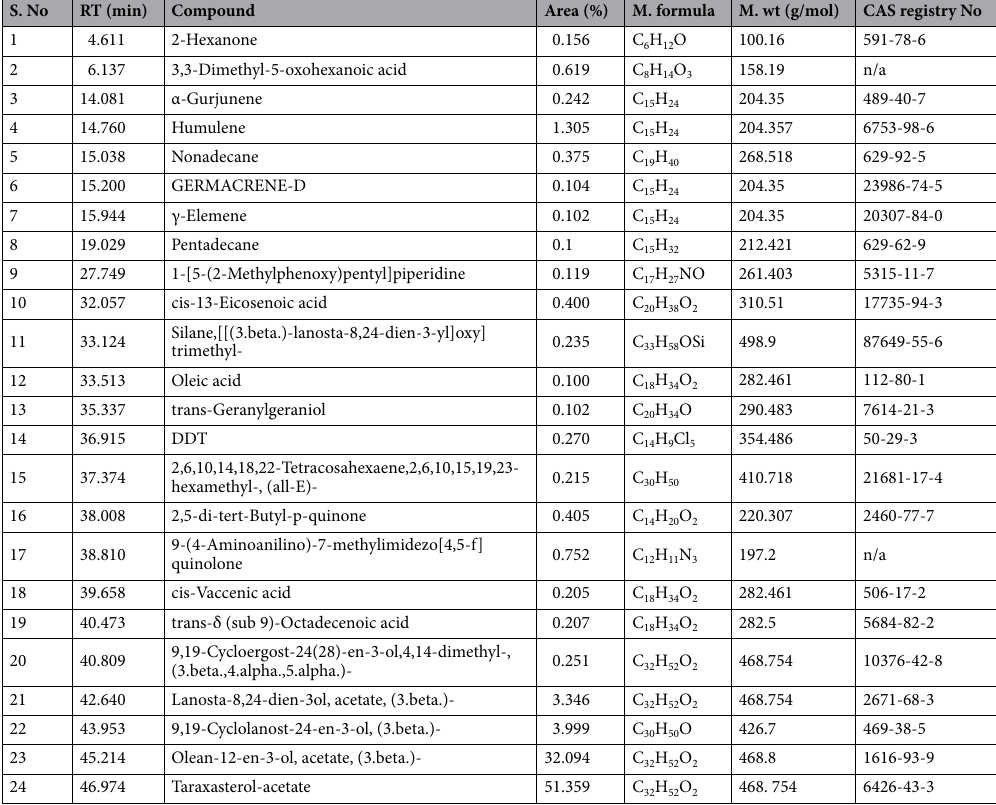
Table 1. Chemical composition of Ficus carica latex detected by GC ‒ MS. The data included in the table clarify the range of twenty-four different bioactive chemical constituents at different concentrations ≥ 0.1 of the total latex content obtained within different retention times. RT, retention time per minute; Compound, active compounds detected by GC ‒ MS; (%), percentage of compound; M. formula, molecular formula; CAS registry No, number assigned to a substance when it enters the CAS REGISTRY database; M. wt, molecular weight of the